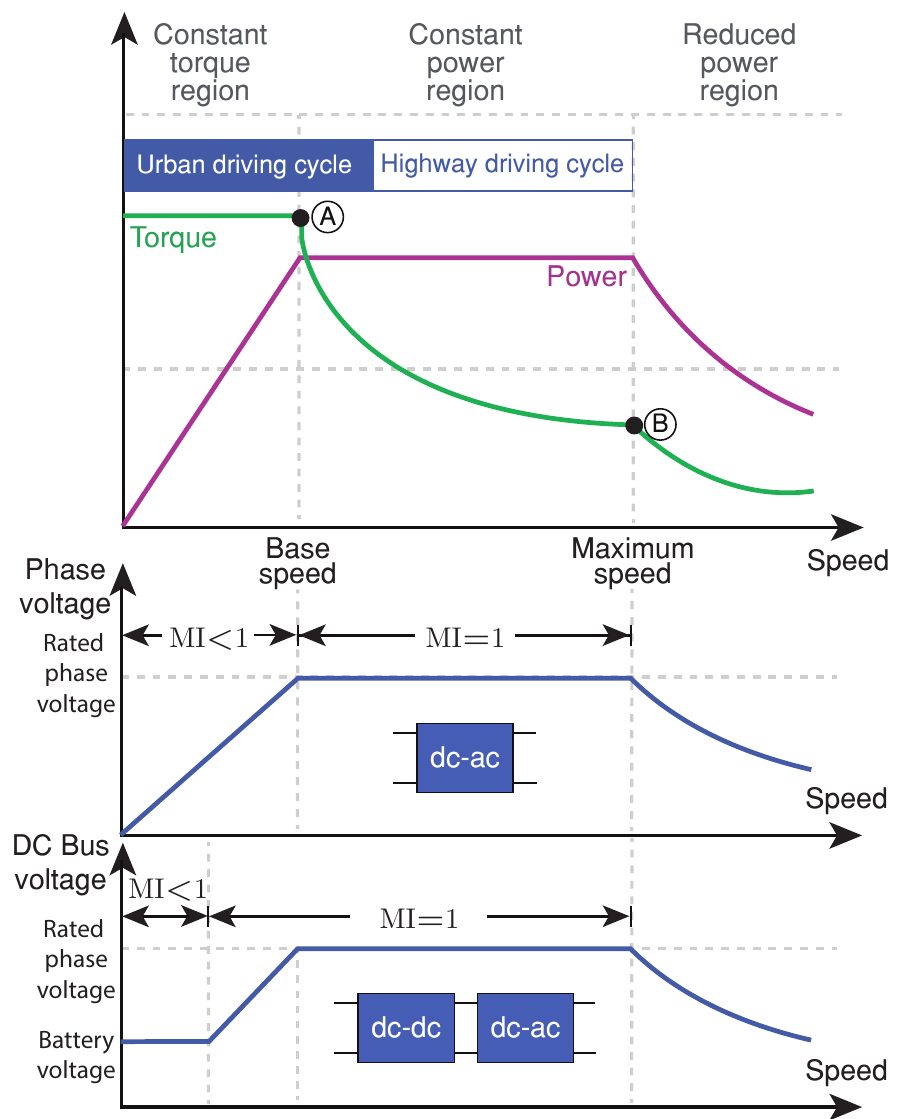
Figure 2. Torque and power requirements for the EV drive systems. An interleaved zero voltage switching (ZVS) version, included in multifunctional power electronic interface and operating at 60 kHz, is presented in [20], achieving high- efficiency measurements. Integration of this bidirectional converter in a new topology is proposed in [24] for a hybrid electric vehicle system. This converter interfaces between two different voltage values corresponding to the battery system and a DC-bus. It is worth noting that this bidirectional converter operates as a boost- or buck-converter depending on whether the motor is in driving or regenerative mode [26]. Therefore, this electric drive topology is more suitable for highway driving cycles (see Figure 2), reducing the system’s efficiency under an urban driving cycle. The latter is because the inverter efficiency cannot be guaranteed under low speeds since the boost converter cannot reduce the DC- bus voltage below the battery voltage [6,27]. A converter with step-up and step-down characteristics, not only will extend the efficient range to urban driving cycle, but will also add more flexibility in designing both battery and